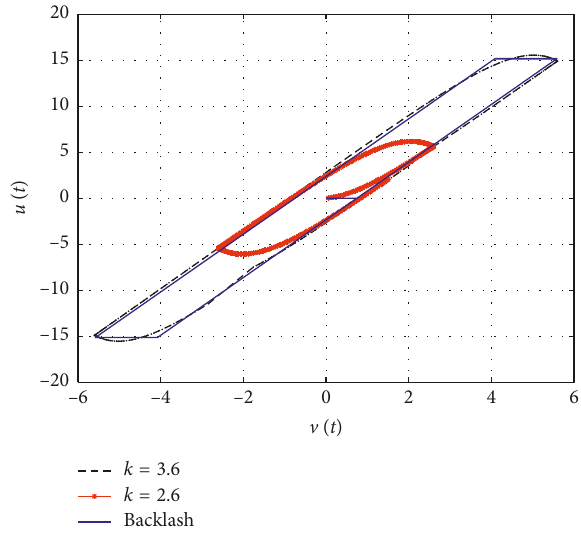
Figure 1: Hysteresis curves given by (2) with α � 1 , c � 3 . 1635, and b � 0 . 345 for v ( t ) � k sin ( 2 . 3 t ) with k � 2 . 6 (red solid line) and k � 3 . 6 (dashed line) to approximate backlash (blue solid